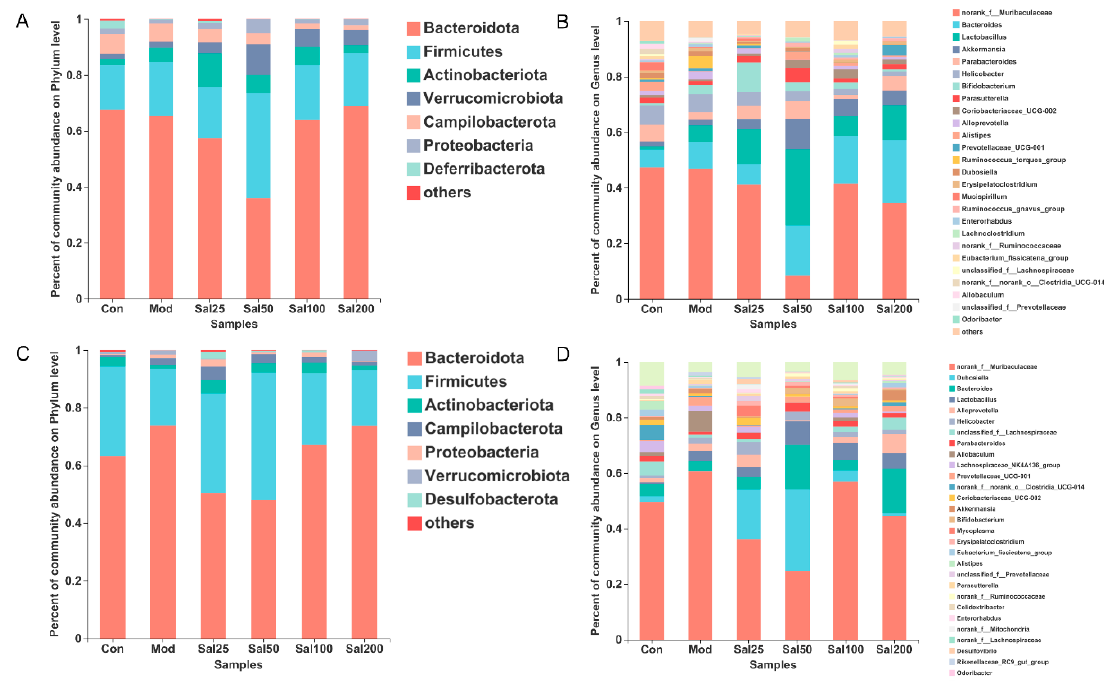
Figure 4. The effects of salidroside on the gut microbiota composition. ( A , C ) The composition at the phylum level after 7 and 14 days, respectively. ( B , D ) The composition at the genus level after 7 and 14 days, respectively.